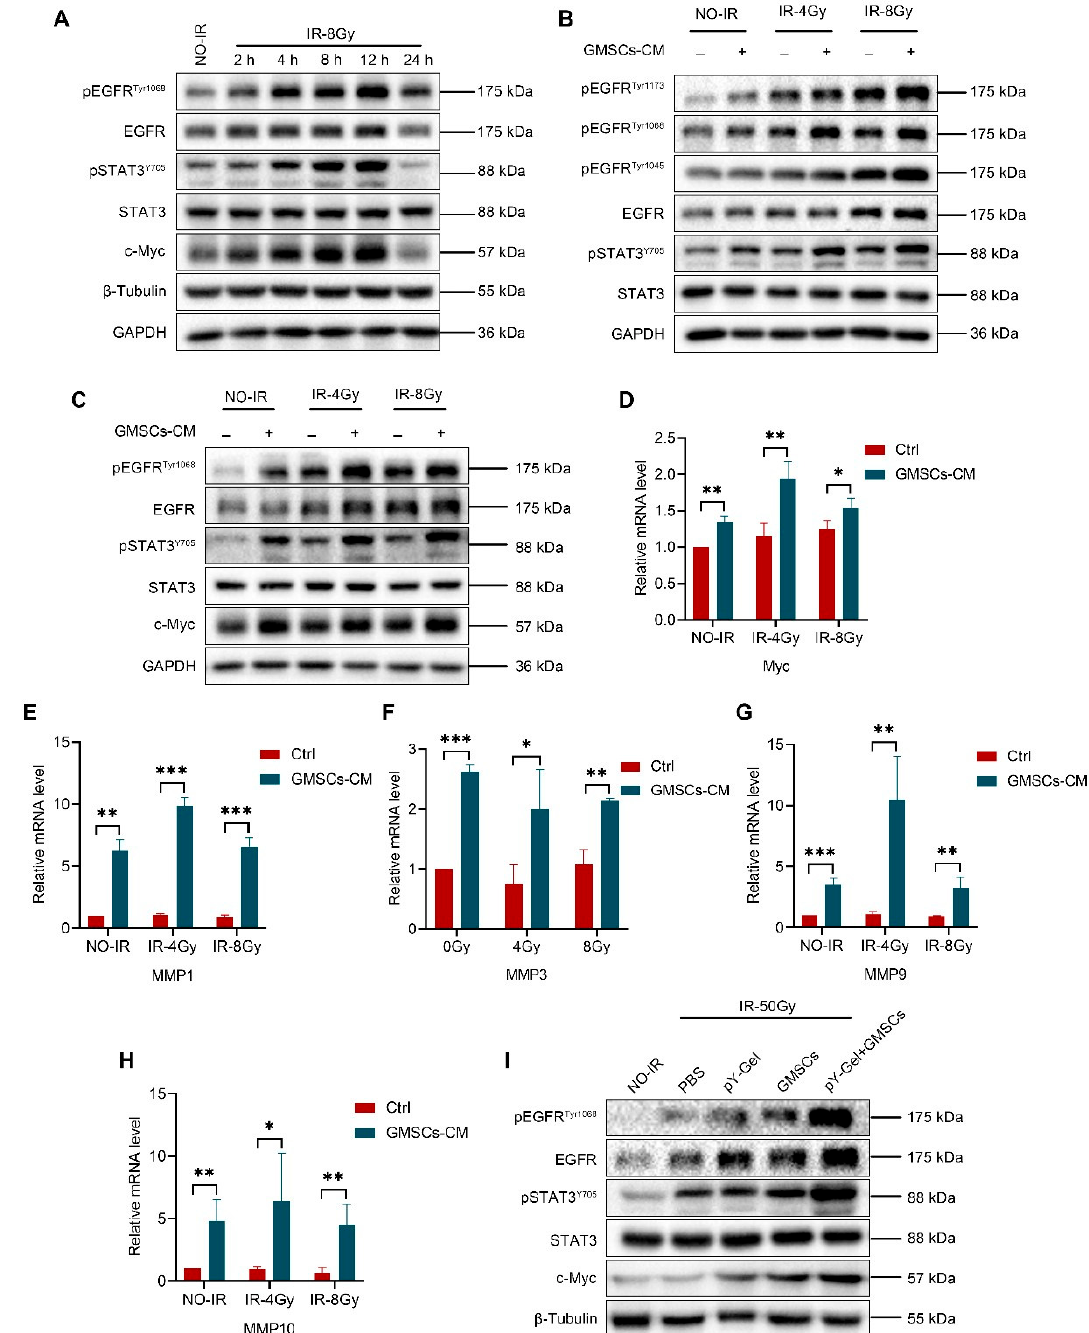
Figure 5. GMSCs regulate IR-induced activation of the EGFR/STAT3 signaling pathway. ( A ) pEGFR Tyr1068 , EGFR, pSTAT3 Y705 , STAT3 and c-Myc expression levels in IR-treated skin cells for the indicated times. ( B , C ) pEGFR Tyr1173 , pEGFR Tyr1068 , pEGFR Tyr1045 , EGFR, pSTAT3 Y705 , STAT3 and c-Myc expression levels in GMSCs-CM-treated skin cells for 6 h after 4 and 8 Gy irradiation. ( D ) Measurement of the expression of Myc by qPCR analysis at 6 h after 4 and 8 Gy irradiation. ( E – H ) Measurement of the expression of MMP1, MMP3, MMP9 and MMP10 by qPCR analysis at 6 h after 4 and 8 Gy irradiation. ( I ) pEGFR, EGFR, pSTAT3 Y705 , STAT3 and c-Myc expression levels in pY-Gel+ GMSCs-treated skin tissues for 30 days after 50 Gy irradiation. Representative results from one of three independent experiments are shown. Data are expressed as the mean ± standard deviation. Statistical comparisons were made by two-sample Student’s t -test, using the SPSS 25.0 software (IBM Corporation, Armonk, NY, USA). * p < 0.05, ** p < 0.01 and *** p < 0.001.